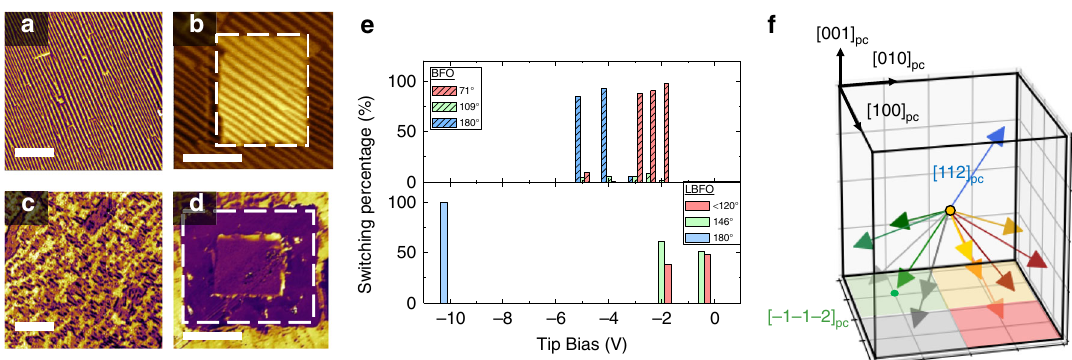
Fig. 3 Ferroelectric switching in BiFeO 3 and Bi 0.85 La 0.15 FeO 3 revealed by PFM. a , c The as-grown IP-PFM images show different domain patterns in 20-nm-thick BiFeO 3 and Bi 0.85 La 0.15 FeO 3 thin fi lms, respectively. b In-plane PFM images of 20-nm-thick BiFeO 3 after PFM electric poling with − 5 V (upward polarized). d In-plane PFM images of 20-nm-thick Bi 0.85 La 0.15 FeO 3 after PFM electric poling with − 10 V (upward polarized). The scale bar is 1 μ m. e The summary of the polarization switching angles for 20-nm-thick BiFeO 3 and Bi 0.85 La 0.15 FeO 3 thin fi lms. f Schematic of ferroelectric polarization switching in Bi 0.85 La 0.15 FeO 3 thin fi